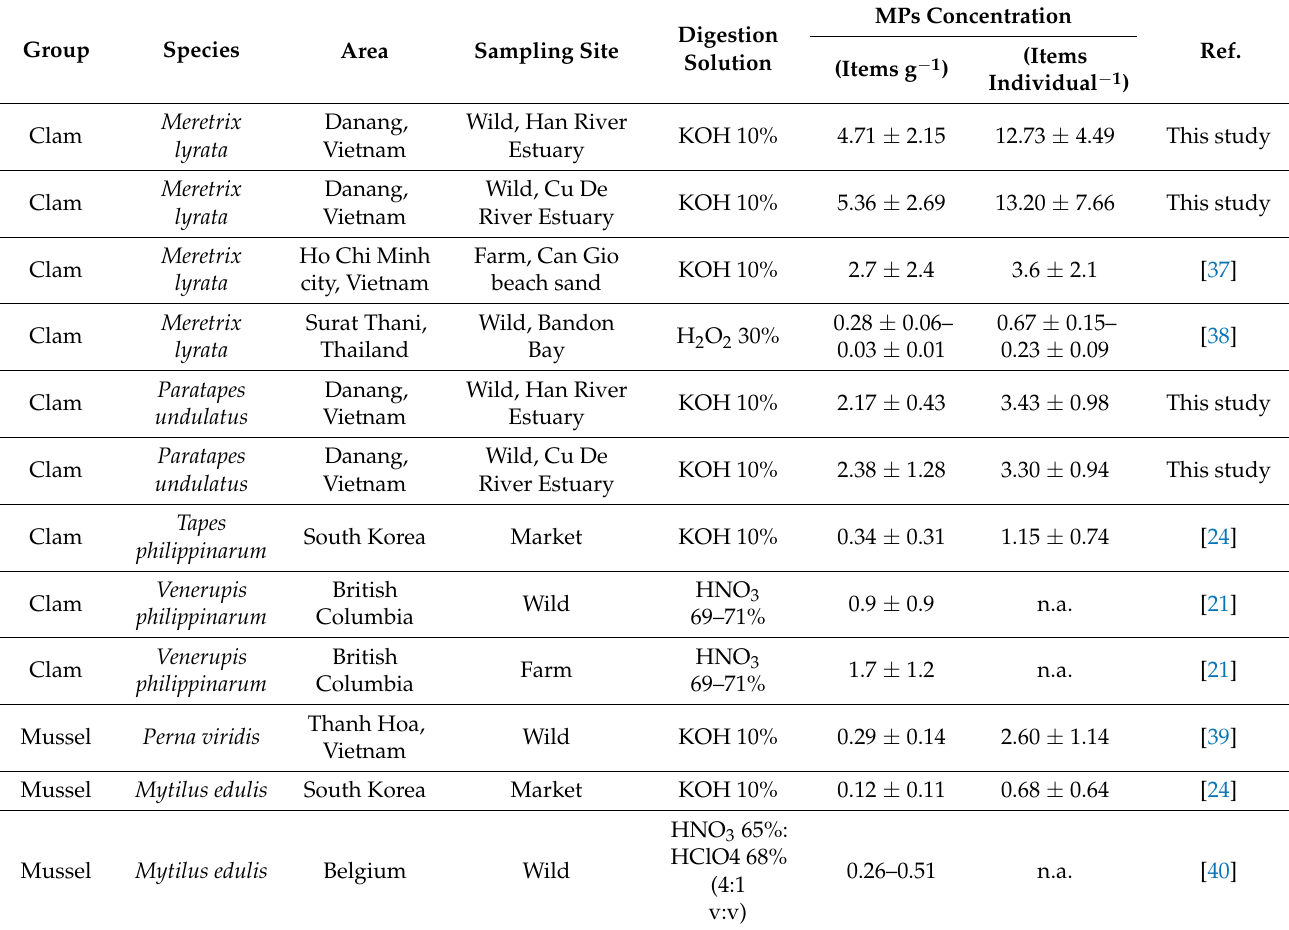
Table 2. Microplastic concentrations in some popular edible bivalves from different